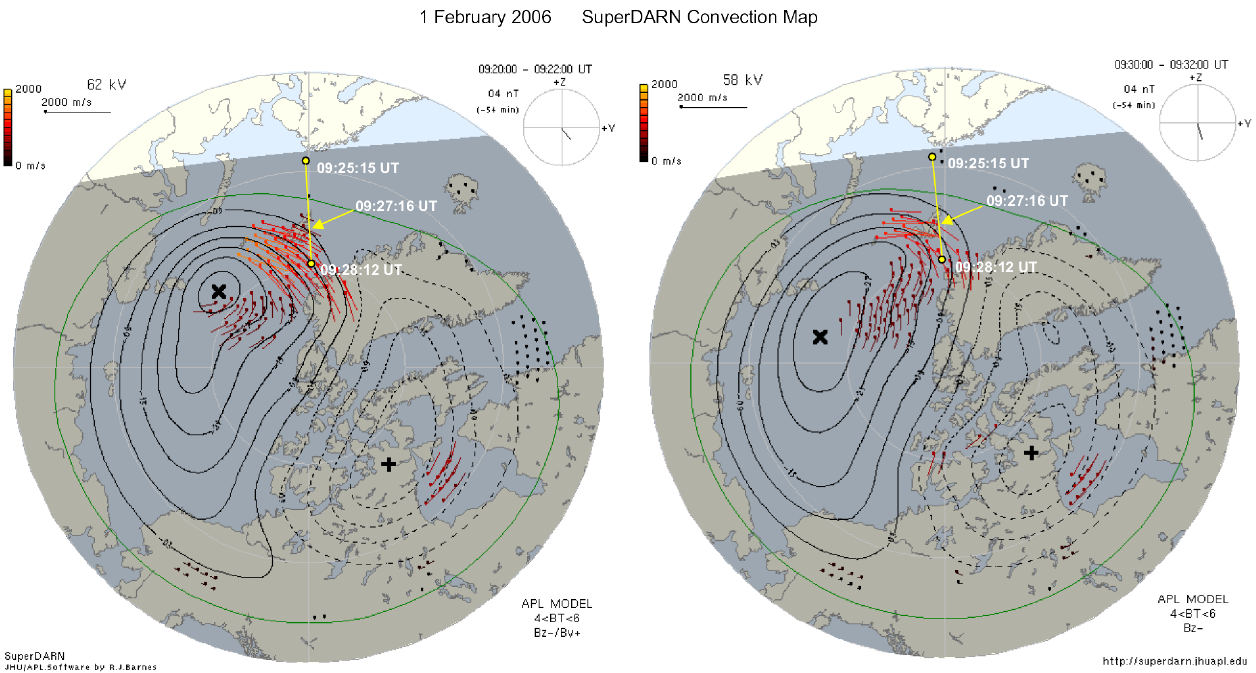
Fig. 7. SuperDARN plasma convection data are shown for 09:20:00–09:22:00UT (left) and 09:30:32UT (right). The satellite trajectory is indicated on both maps. The closest pass to the ESR 32m antenna is about